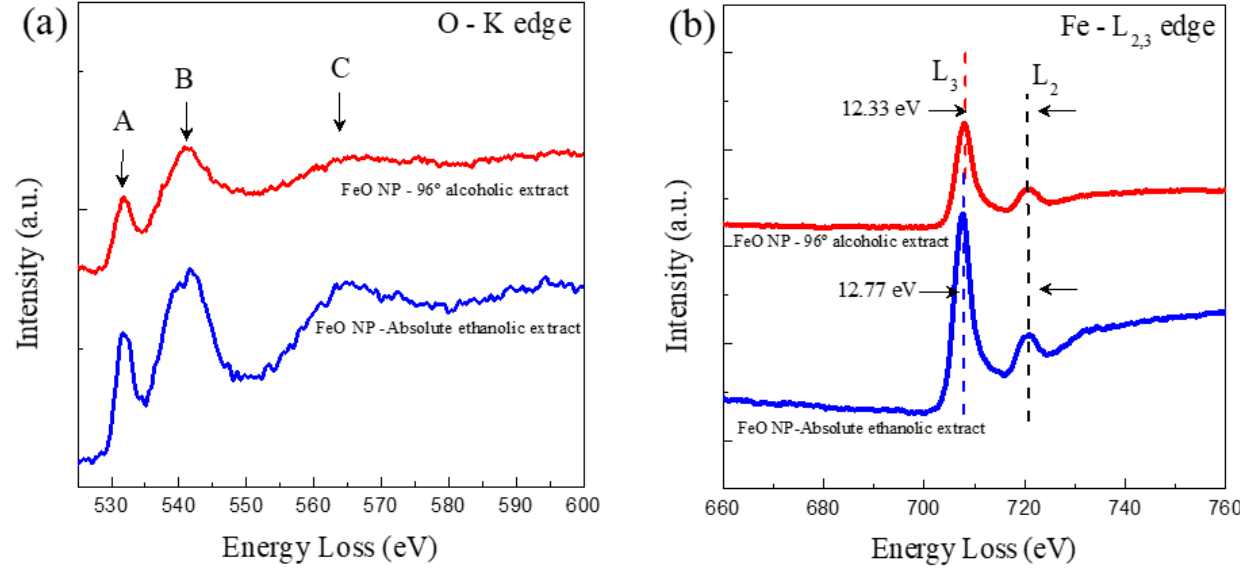
Figure 8. EELS spectra of O-K edges ( a ) and Fe- L 2,3 edges ( b ) acquired from a FeO NP 96% alcoholic extract (red curves) and FeO NP absolute ethanolic extract (blue curves), respectively.